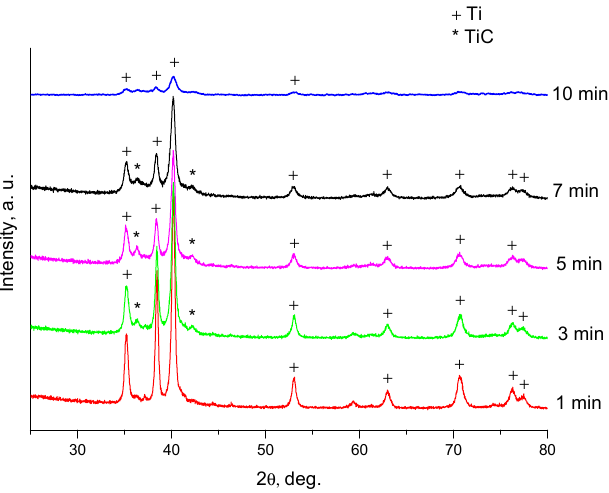
Figure 3. Morphology of mechanocomposite particles formed after 1 min ( a ), 10 min ( b ) of ball milling. The composition of the mixture is Ti+0.3C.